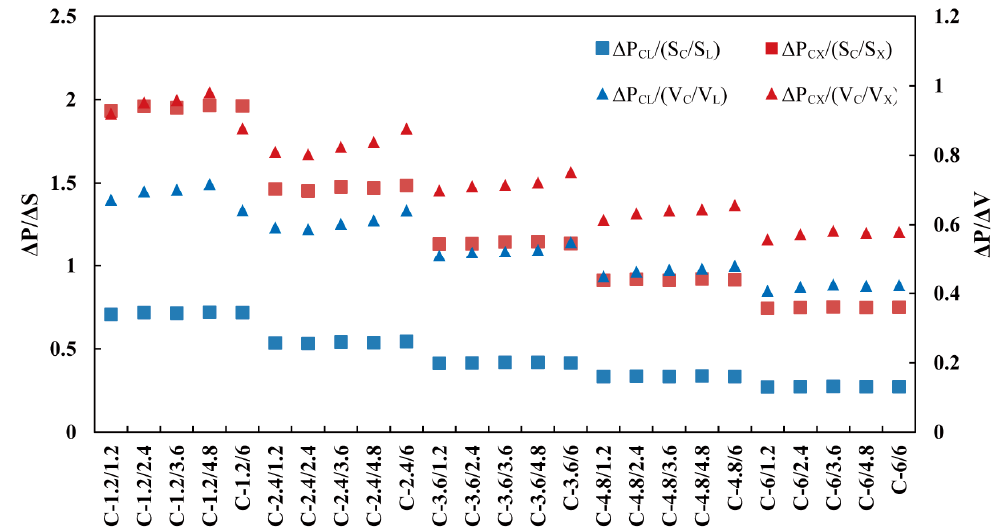
Figure 15. Improvement over bend region and bend volume (1.2 ≤ r ≤ 6).